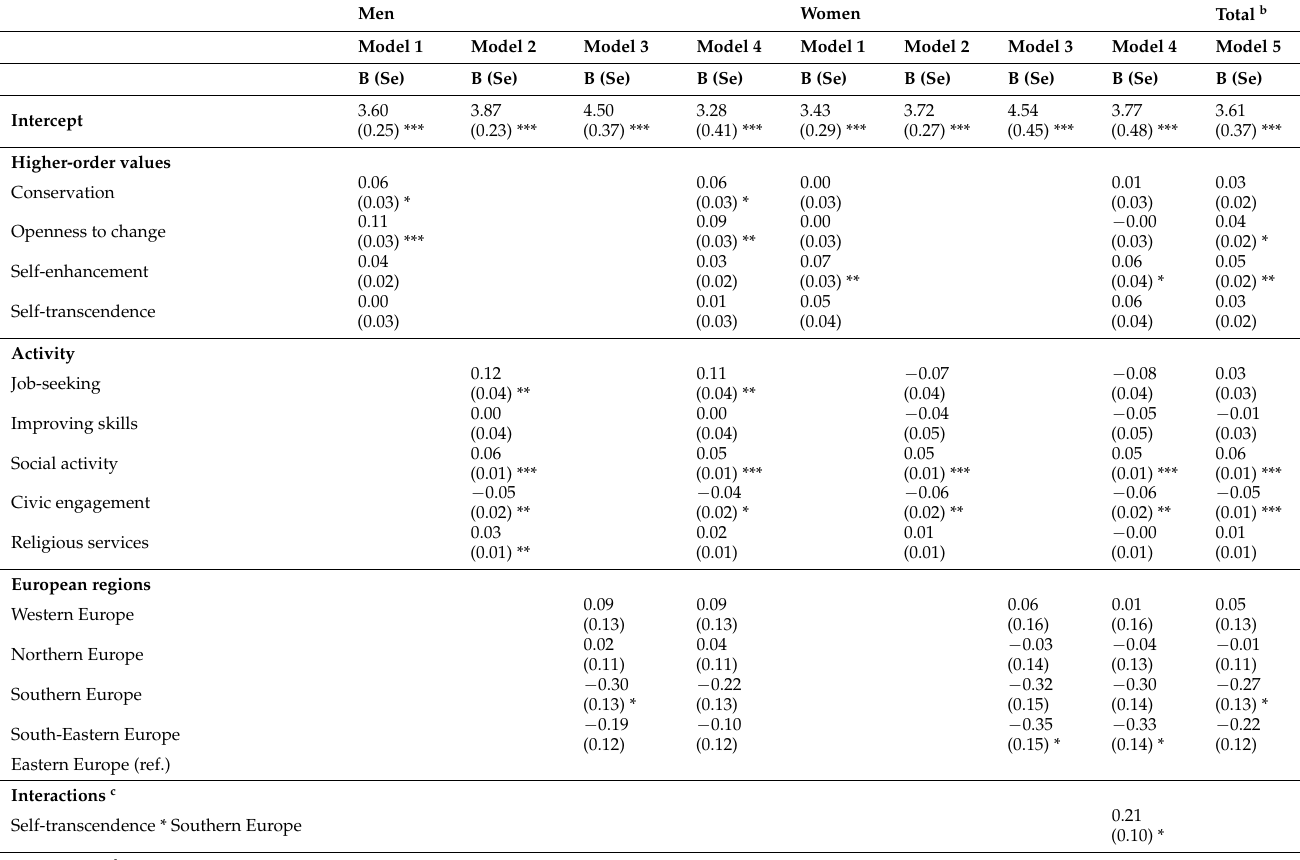
Table 5. Multilevel models a for the associations between SRH and values in NEET men (n = 2100). and women (n = 1742).